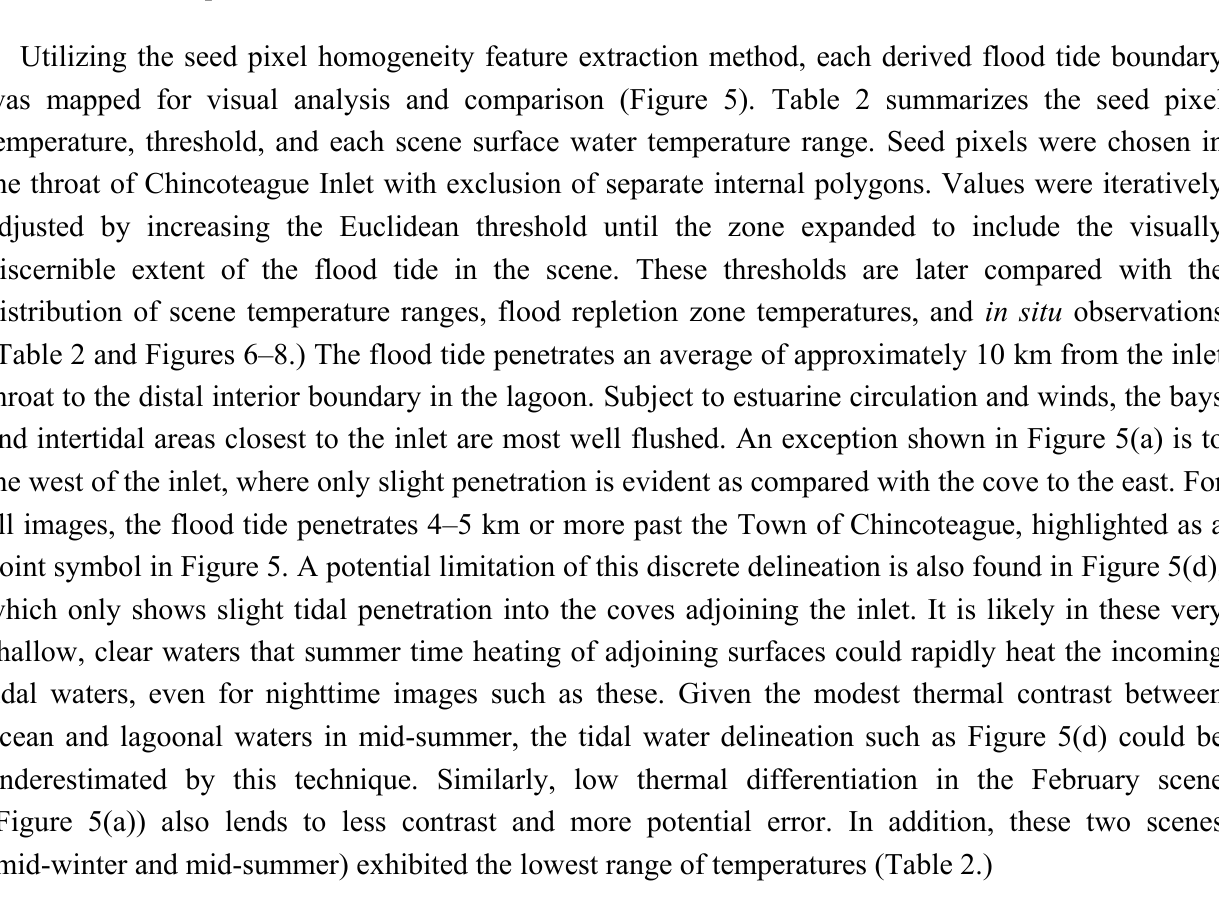
Figure 5. Derived surface water temperatures and repletion footprints for each image highlighting the Town of Chincoteague (  ) for location reference ( a ) 19 February 2005, ( b ) 19 March 2006, ( c ) 23 May 2004, and ( d ) 3 July